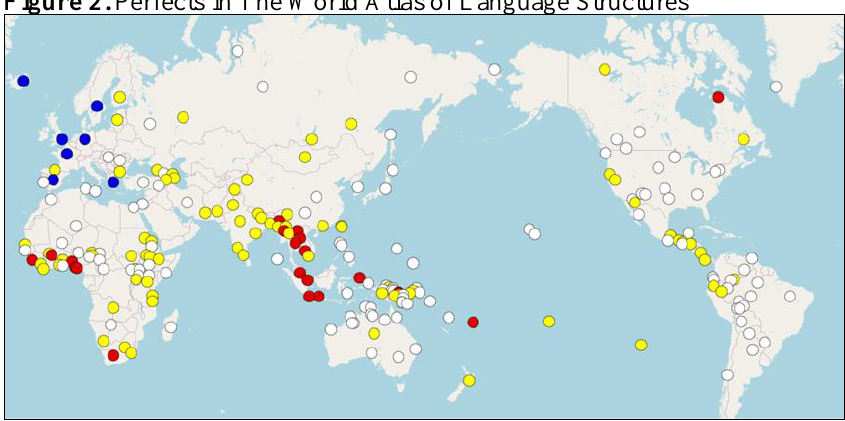
Source: Dahl & Velupillai (2013); Feature 68A,